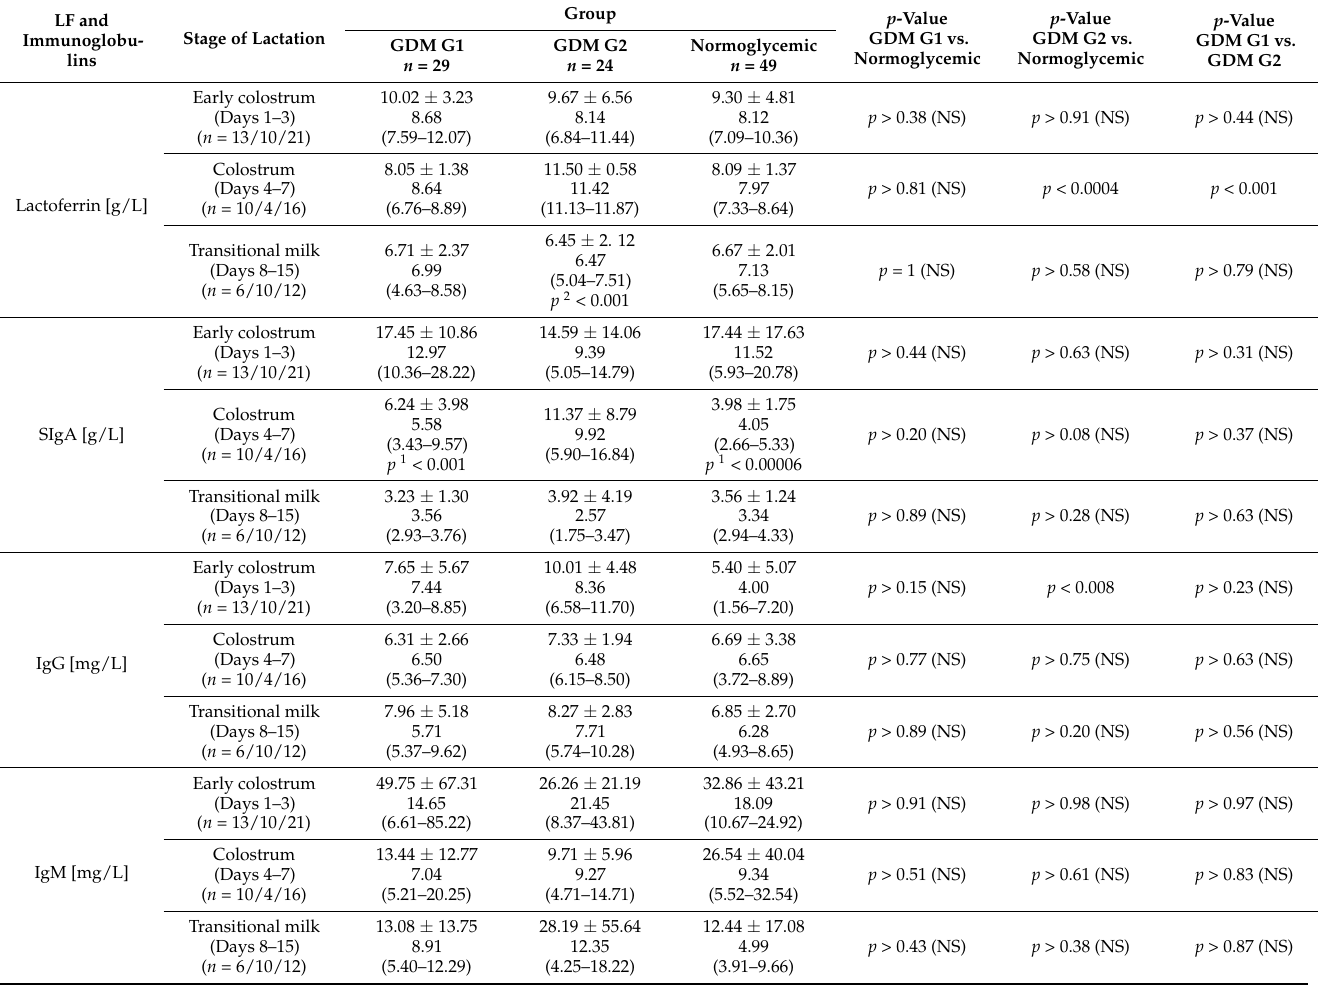
Table 2. Concentrations of lactoferrin and immunoglobulins in milk from diabetic mothers during milk transformation from early colostrum to the transitional